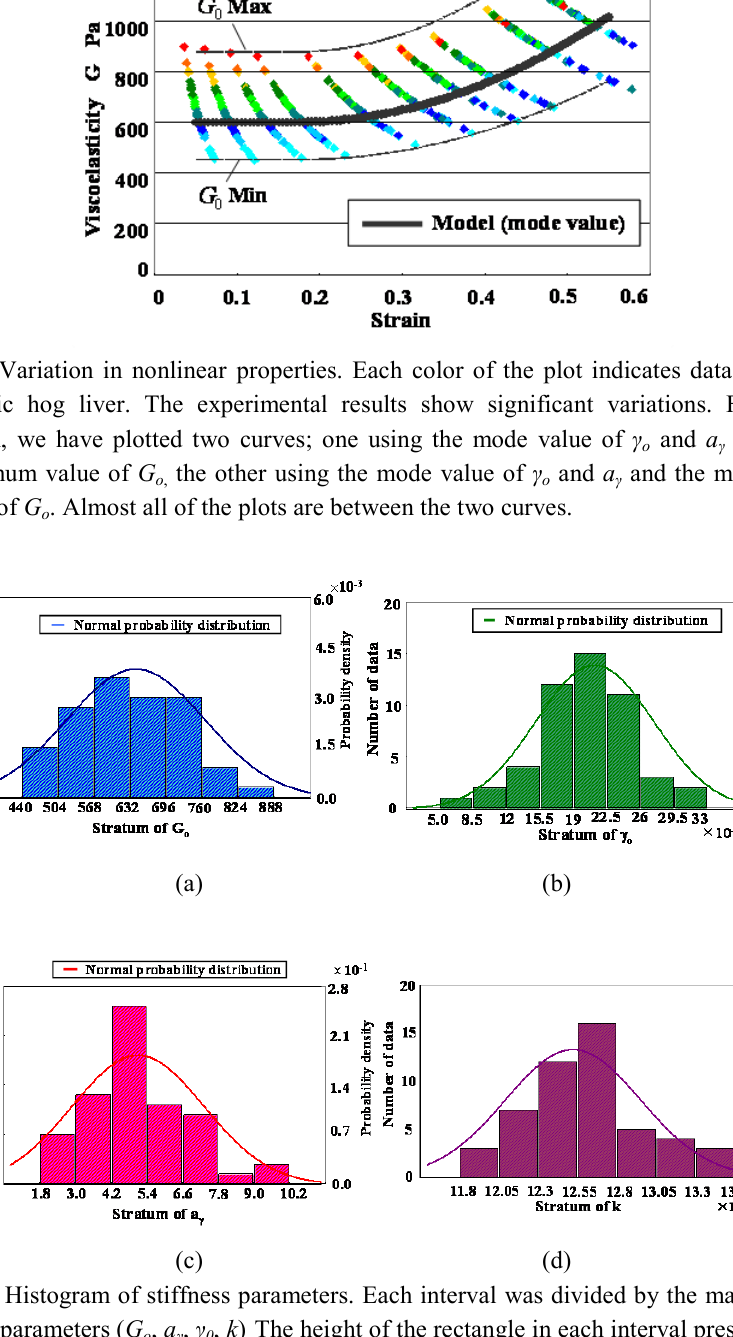
Fig. 6 Histogram of stiffness parameters. Each interval was divided by the magnitude of the parameters ( G , a , γ , k ) The height of the rectangle in each interval presents the . o γ 0 data number and probability density within that interval. These results indicate that the and γ ) exhibited large variations compared parameters with respect to nonlinearity ( a γ 0 to the parameters with respect to viscoelasticity (G , k o